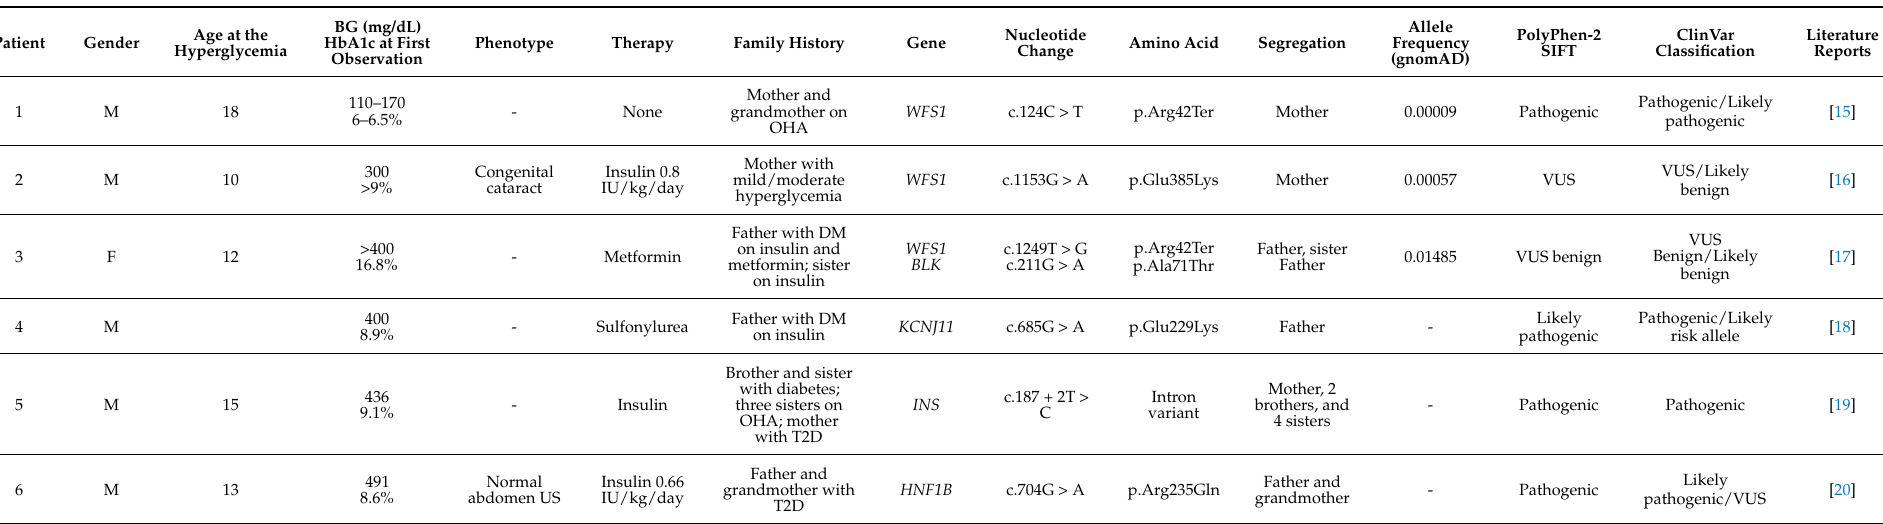
Table 1. Summary of clinical, biochemical, and genetic data of the six patients who turned out as positive at NGS for a variant of uncertain significance (VUS), likely pathogenic or pathogenic. All the variants were inherited in